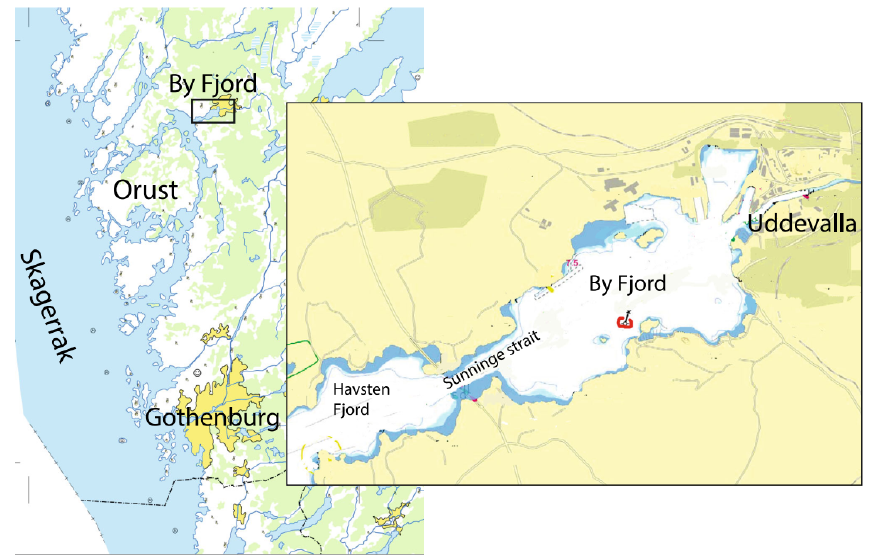
Figure 7. Map of the BOX (Baltic deep-water Oxygenation) sea trial location in By Fjord [43].